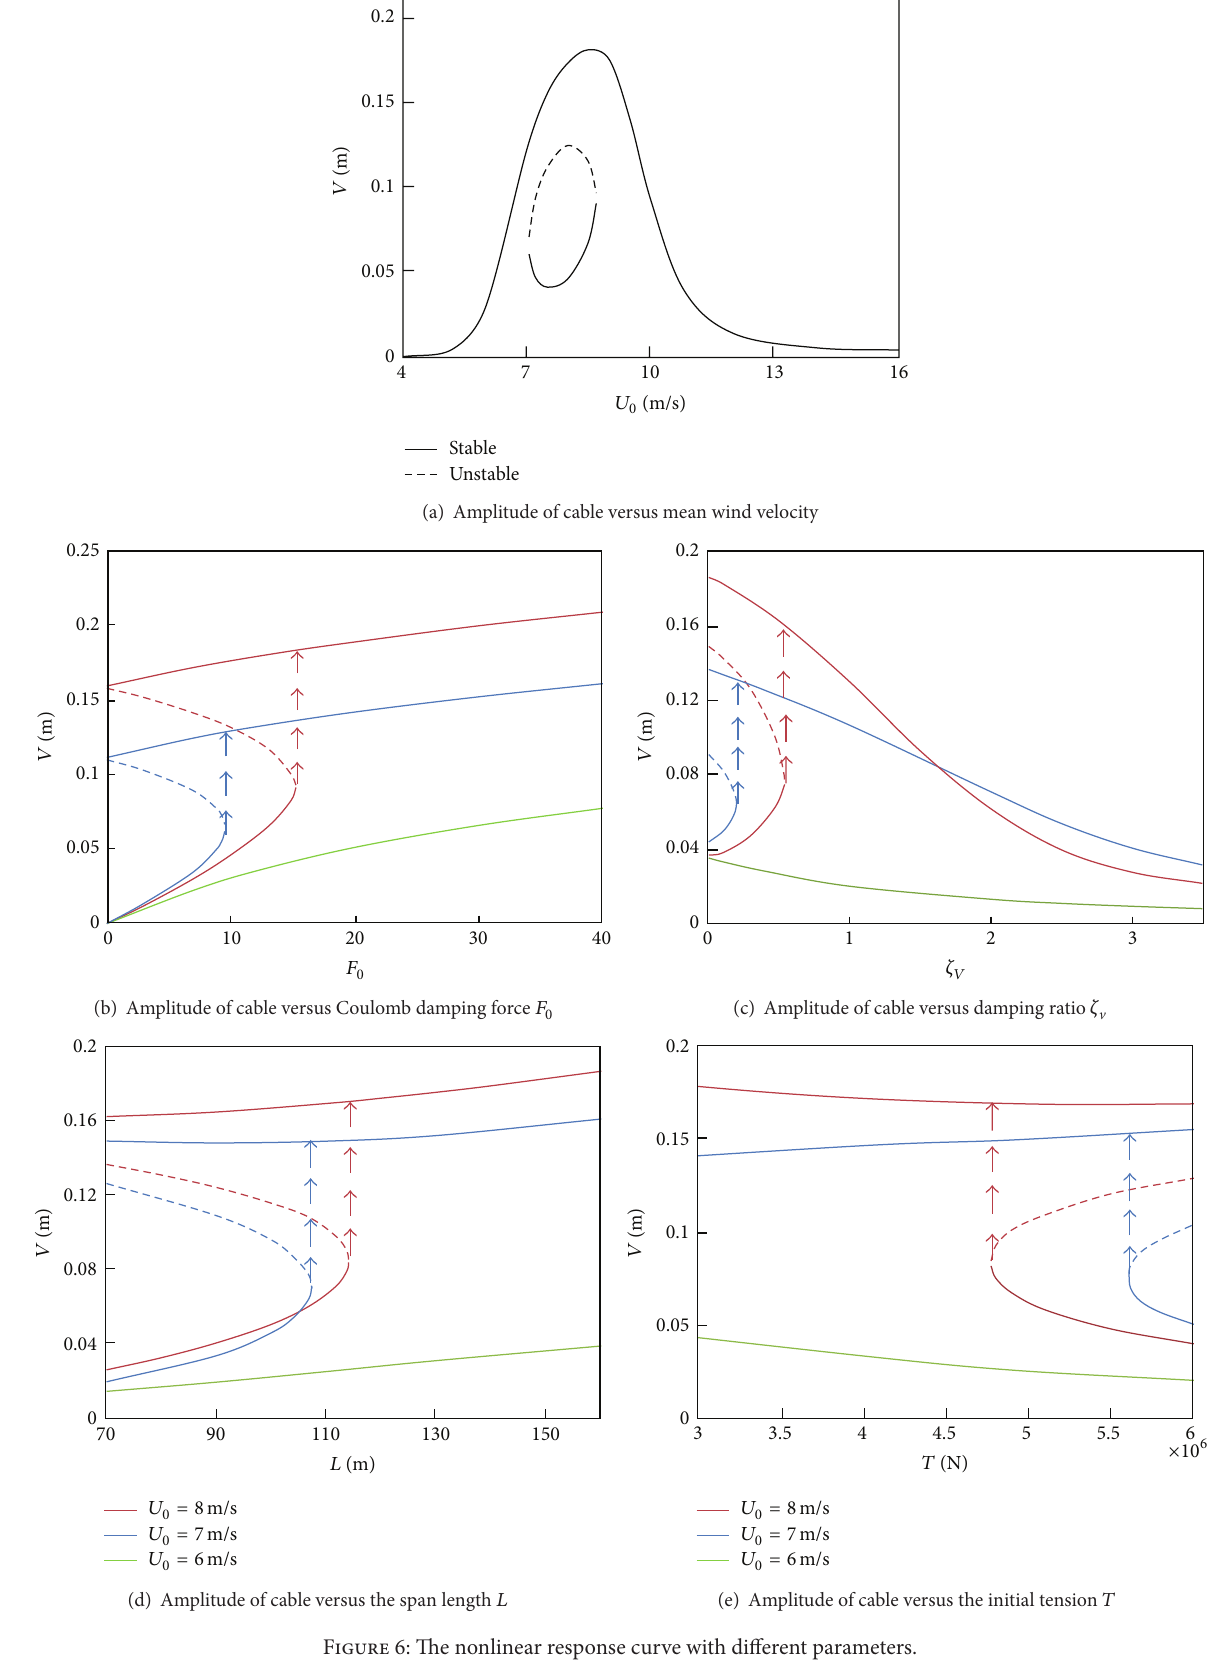
Figure 6: The nonlinear response curve with different